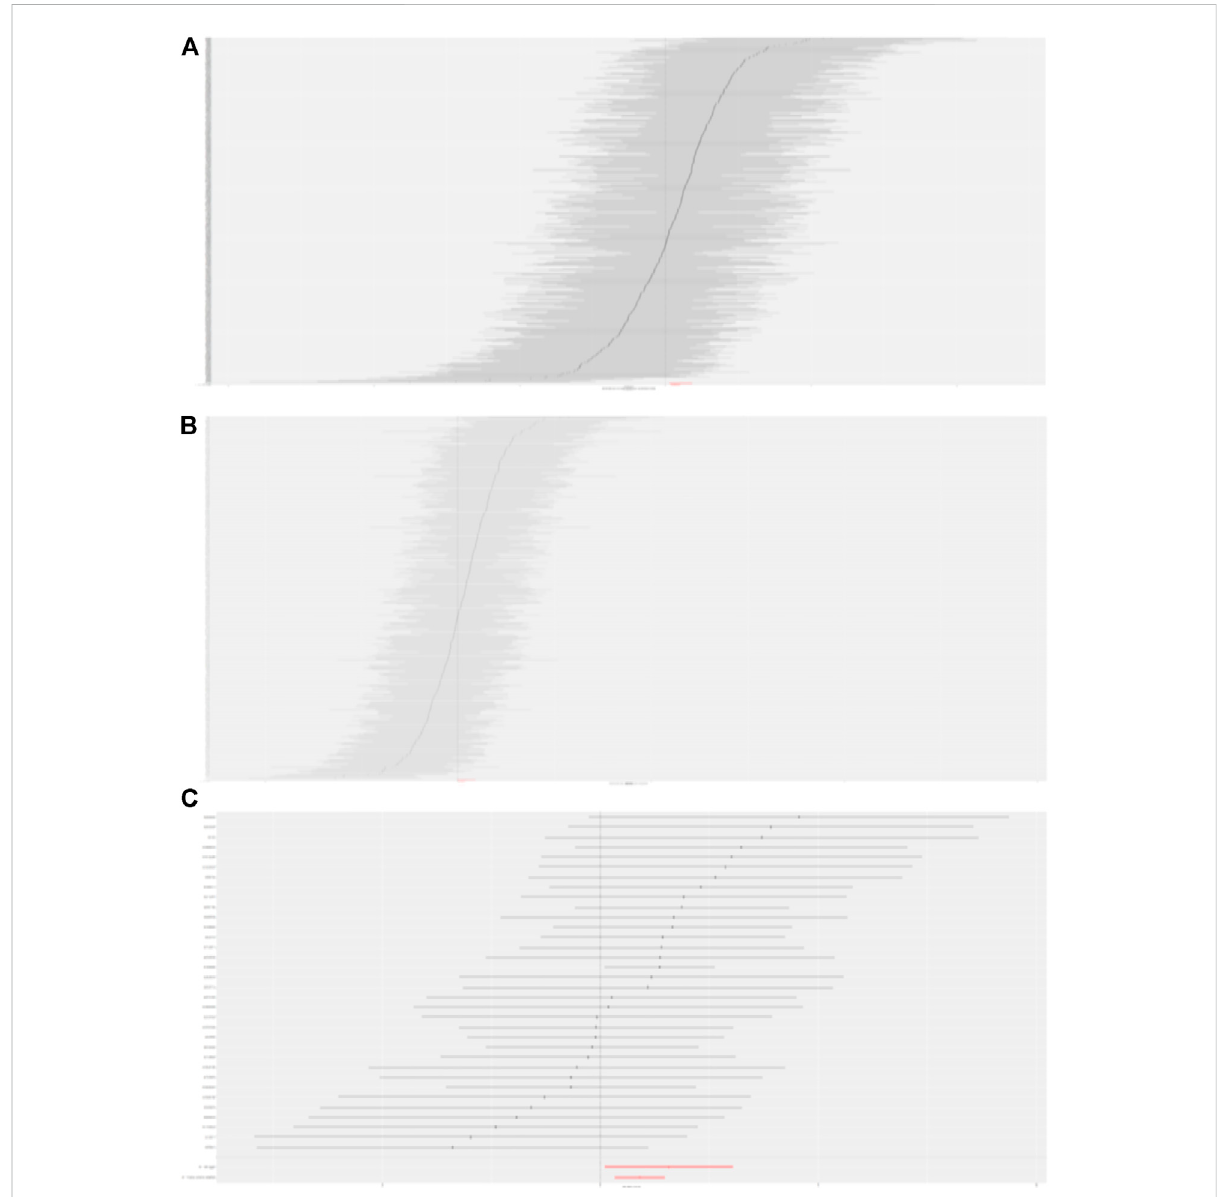
ForestplottovisualizecausaleffectofeachSNPonDKD. (A) CausaleffectofBMIonDKD. (B) CausaleffectoftrunkfatmassonDKD. (C) Causal effect of WC on